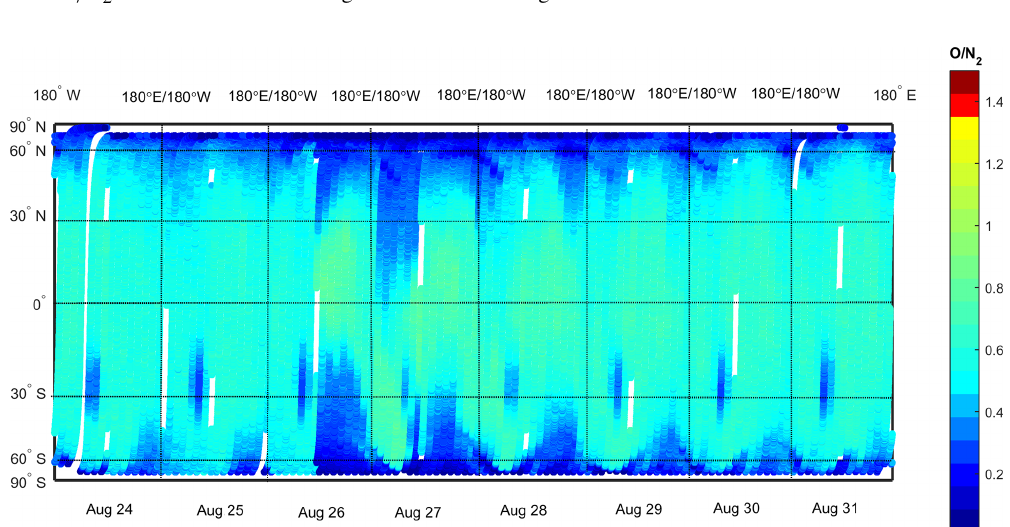
Figure 11. Column O / N 2 from IPM around the magnetic storm of 26 August 2018.